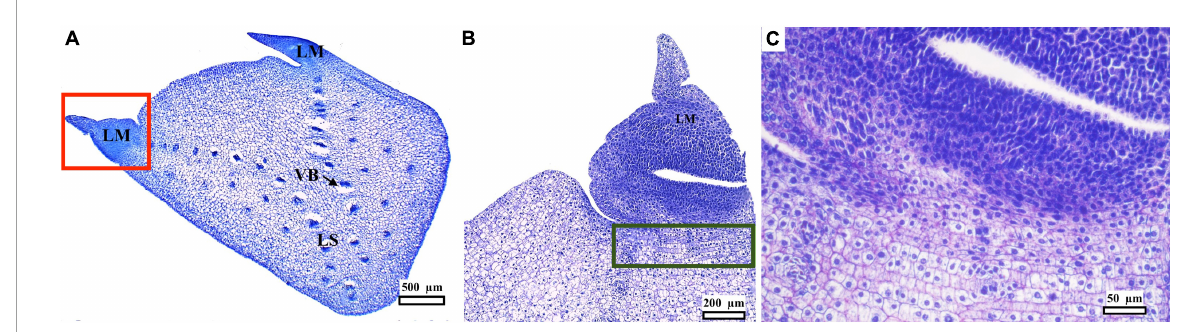
FIGURE2 Histological analysis of a peach palm transverse section dissected from initial explants ( Figure 1F ). Medial transverse section, with leaf sheath margin (LM), leaf sheath (LS), in concordance with Figure 1G , and vascular bundles (VB) (A) . Magnification of LM (red square) showing dense cells in the LM and denoting the responsive and competent tissue beneath its base (green rectangle) (B) . Further magnification of the responsive zone just underneath the LM (C) . Black bars scale equivalent to 500 µ m (A) , 200 µ m (B), and 50 µ m (C) .